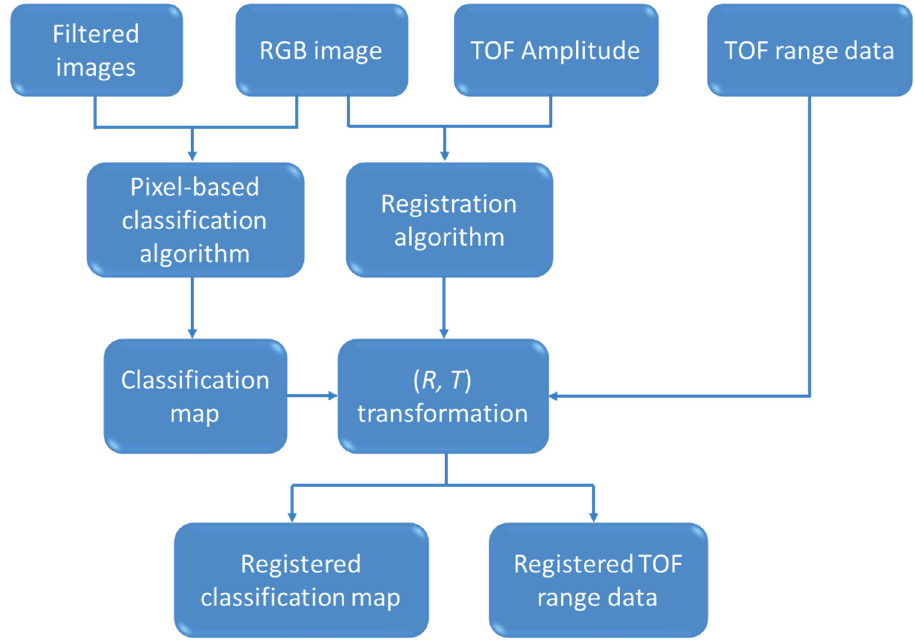
Figure 3. Inputs and outputs of the proposed pre-processing